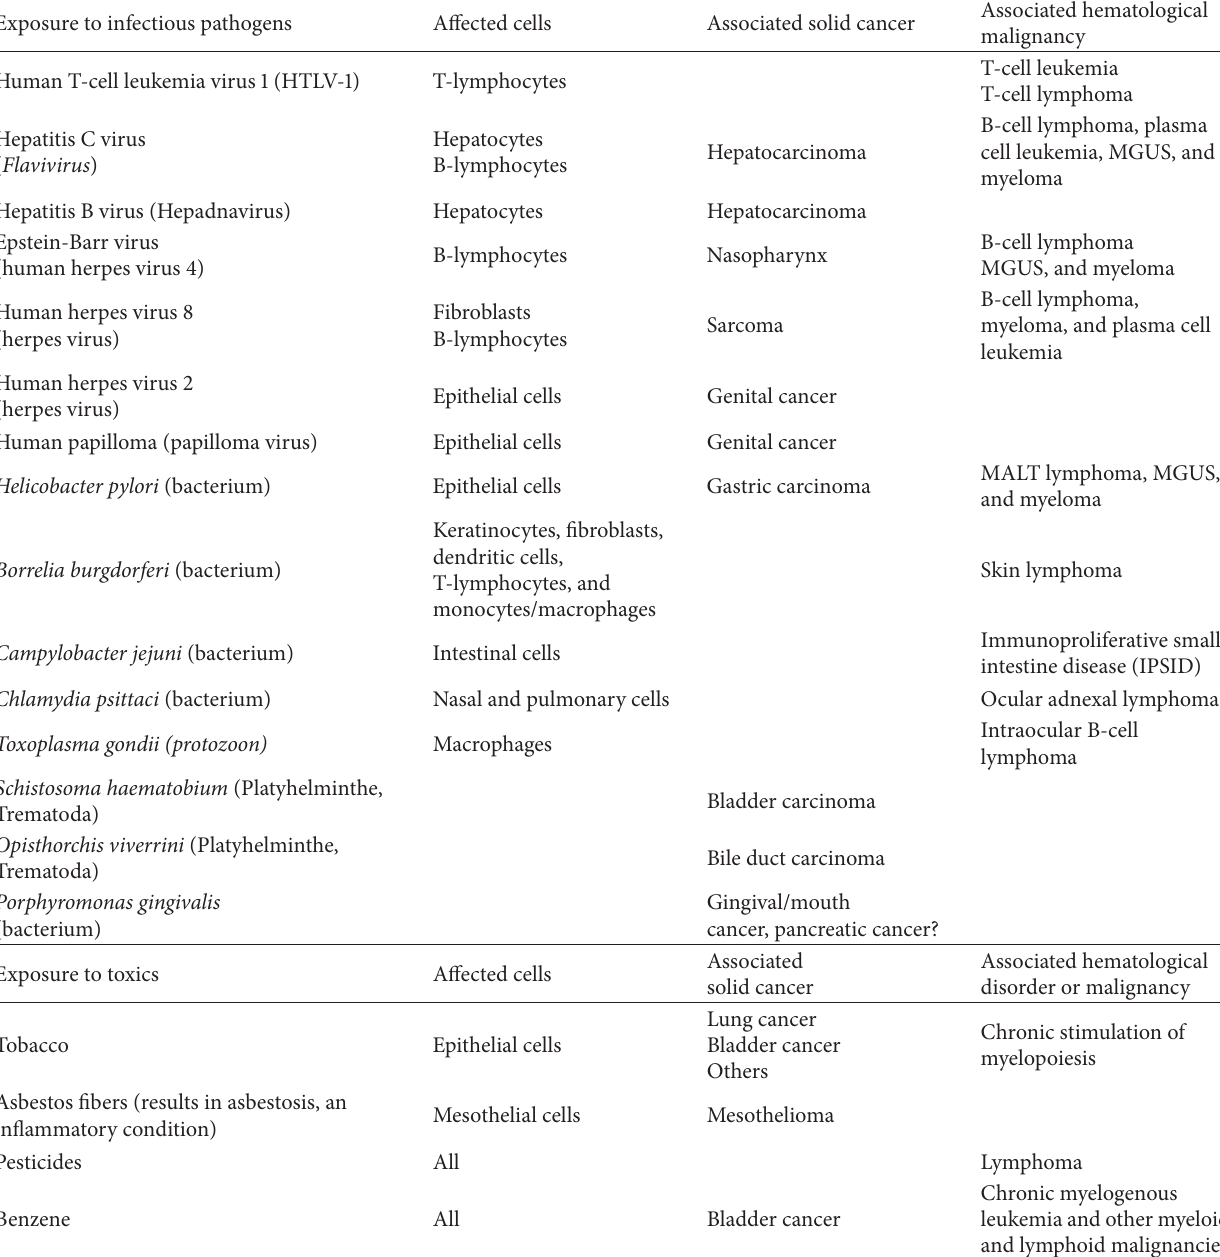
Table 2: Infectious pathogens and toxic compounds known to be associated with chronic inflammation and solid and blood cancers. Exposure to infectious